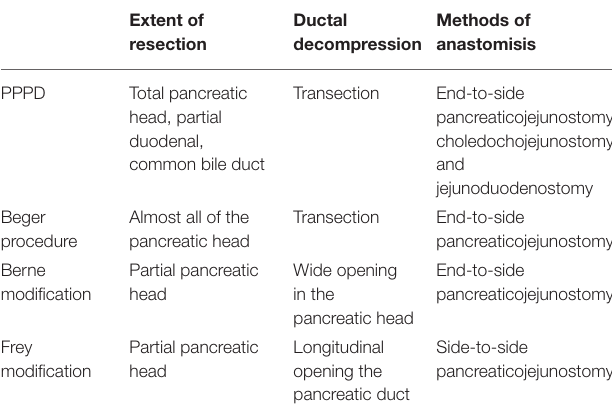
TABLE 3 | Differences and similarities of the operations for